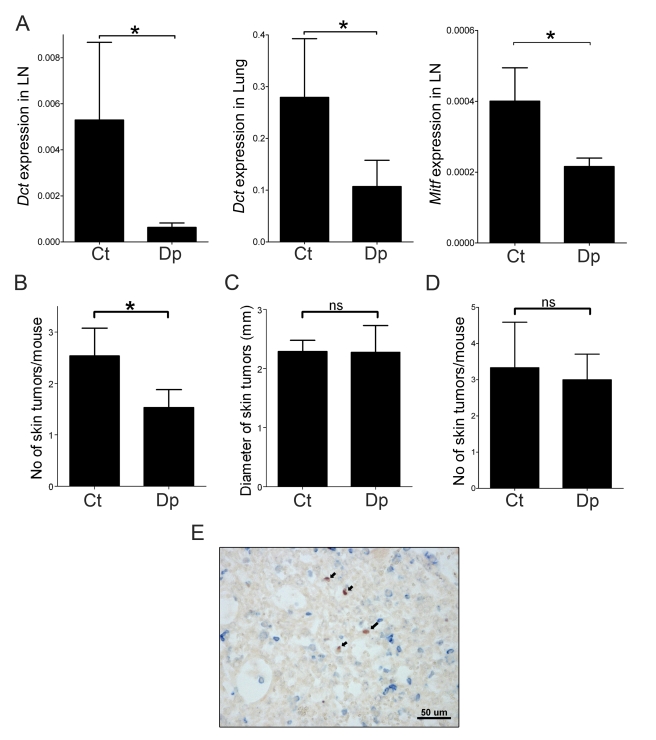
PMN-MDSC stimulate tumor cell dissemination and metastatic outgrowth.(A) Dissemination of tumor cells to the draining mandibular lymph nodes (from 12 control and 20 depleted mice) and lungs (from 11 control and 11 depleted mice) was assessed by measuring ectopic expression of Dct and Mitf by qRT-PCR. The graph shows the relative gene expression normalized to GAPDH in mice injected with the control (Ct) or the anti-Ly6G antibody (Dp) (depletion scheme A). Bars represent mean ± SEM. *p<0.05, two-tailed t test. (B) Decreased number of cutaneous tumors in mice depleted from PMN-MDSC. Data are from 11 control and 11 PMN-MDSC-depleted mice (depletion scheme A). Bars represent mean ± SEM. *p<0.05, two-tailed Wilcoxon matched-pairs test. (C) Depletion of PMN-MDSC does not affect the size of cutaneous tumors. The depletion scheme A was used, but similar results were obtained with depletion scheme B (Figure S4). Bars represent mean ± SEM. ns, non-significant. (D) Delayed depletion of PMN-MDSC has no effect on the incidence of cutaneous metastases. Depletion scheme B was used. Data are from four control (Ct) and six PMN-MDSC-depleted (Dp) mice. Bars represent mean ± SEM. ns, non-significant. (E) Disseminated melanoma cells found in the lungs of 7-wk-old mice are mostly individual cells. Red, S100B; blue, CD45.